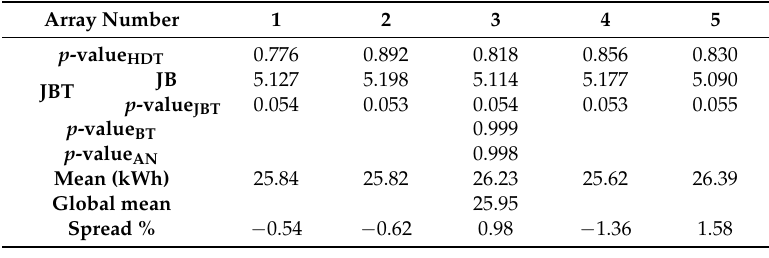
Energies 2018 , 11 , x FOR PEER REVIEW